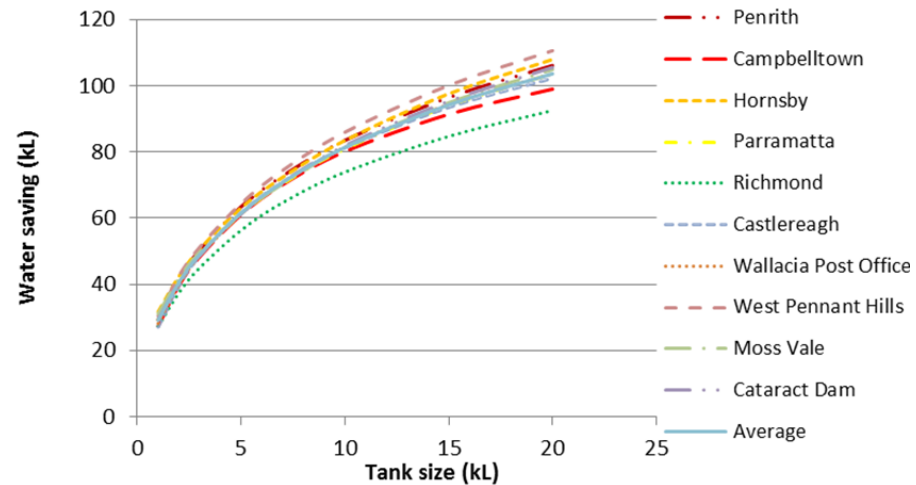
Figure 8. Water savings from a RWHS for combined use (considering the daily rainfall data of all the years on record).